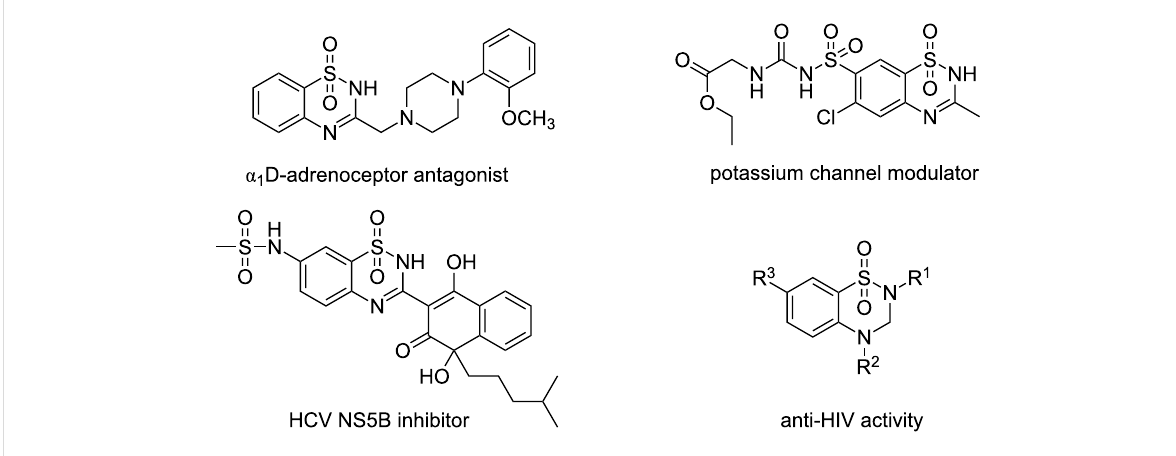
Scheme 1: Selected benzothiadaiazine 1,1-dioxides with potent biological activities.